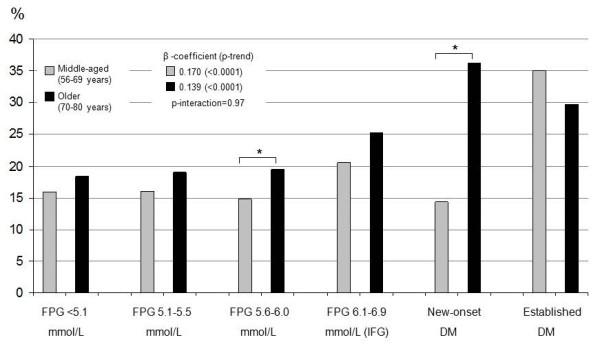
Proportion of women reporting low self-rated health. The figure shows the proportion of women reporting low SRH for each of the six glucometabolic status groups defined in the text. β-coefficients and p-values for trends from the 1st to the 6th groups are also shown. Brackets denote differences between age groups within each glucometabolic status group. * p < 0.05.